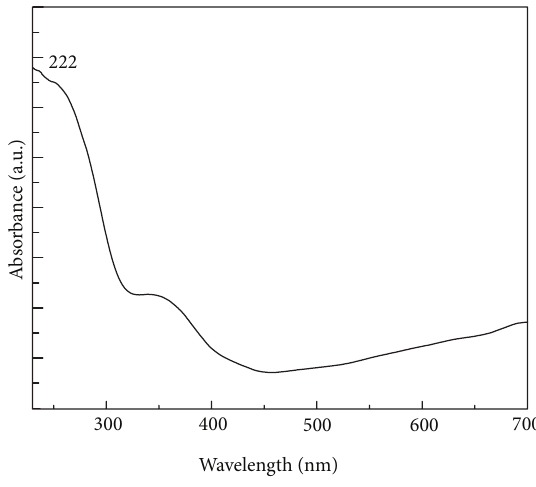
Figure 5: UV-Vis absorption spectrum of CaNb 2 O 6 nanopowder.